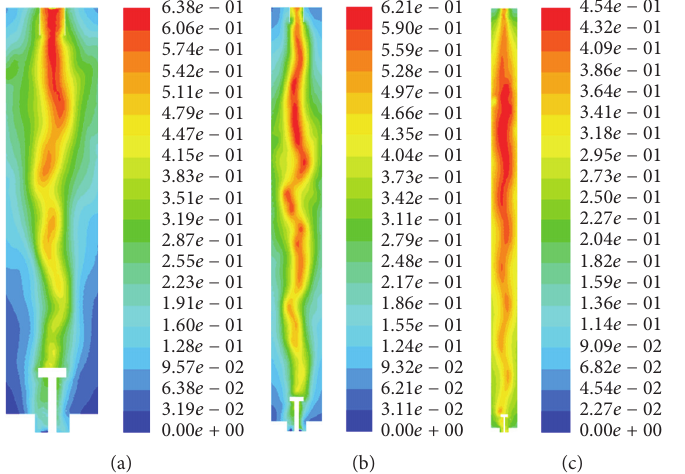
Figure 4: The volume fraction of gas with different lengths of the separator: (a) 𝐿 𝑠 = 440 mm; (b) 𝐿 𝑠 = 840 mm; (c) 𝐿 𝑠 = 1600mm.